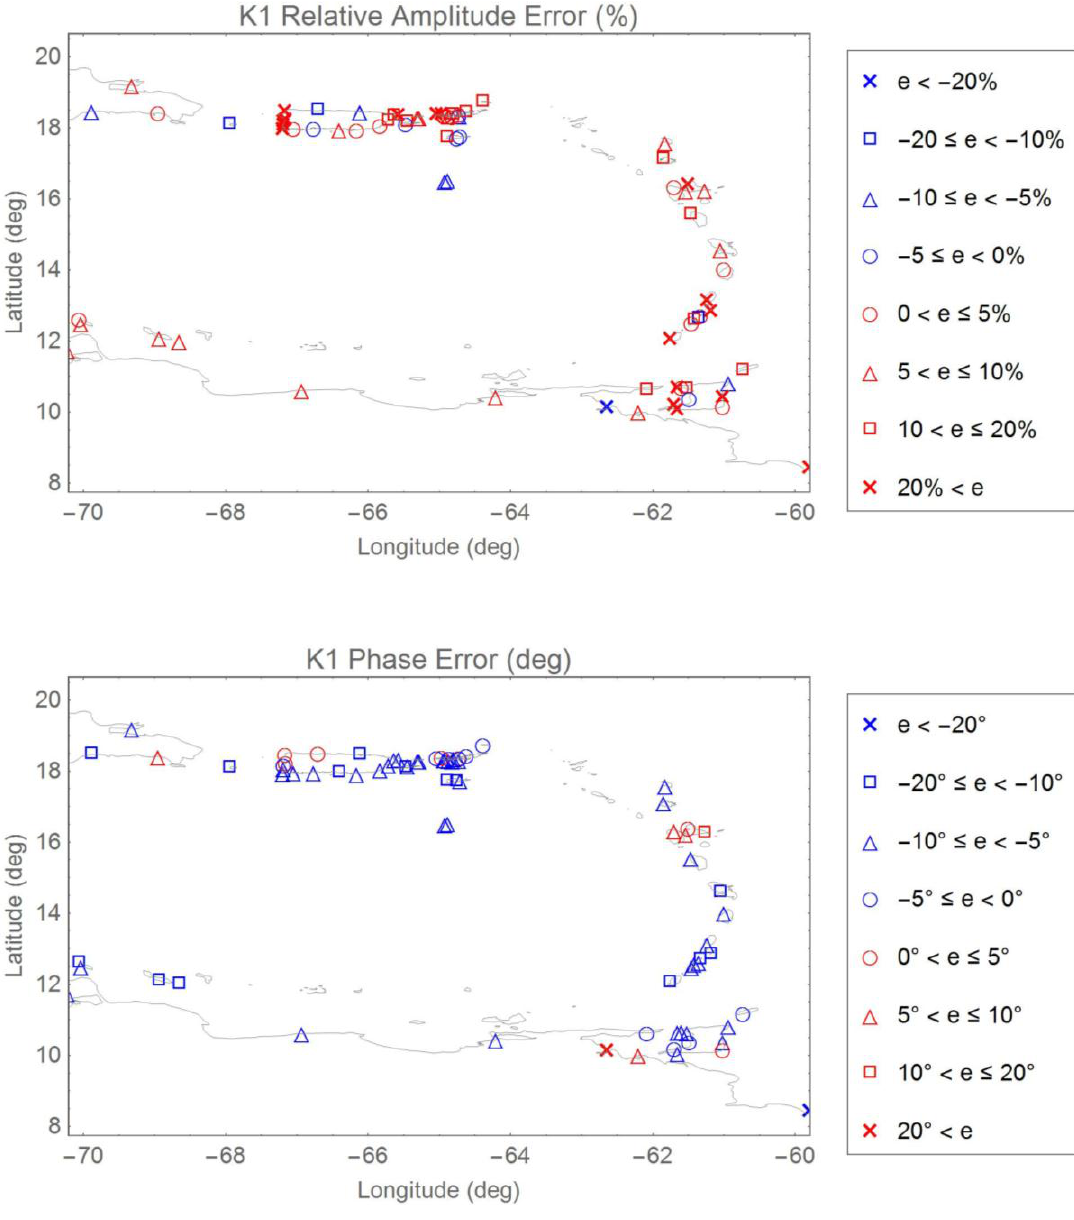
Figure C3. Distribution of relative amplitude and absolute phase errors for the K 1 constituent: Caribbean Sea.